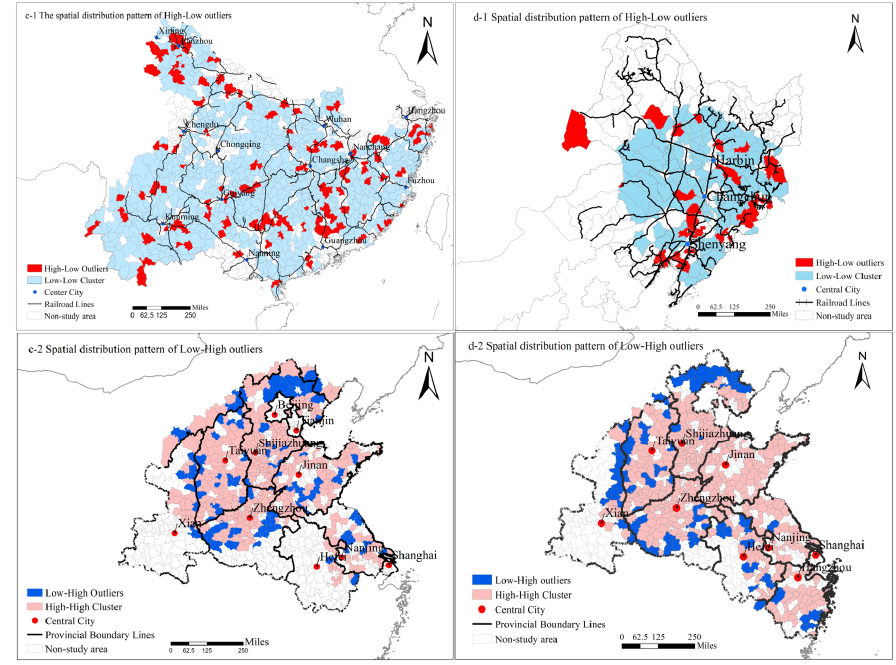
Figure 5. Spatial distribution pattern of county sprawl outliers.